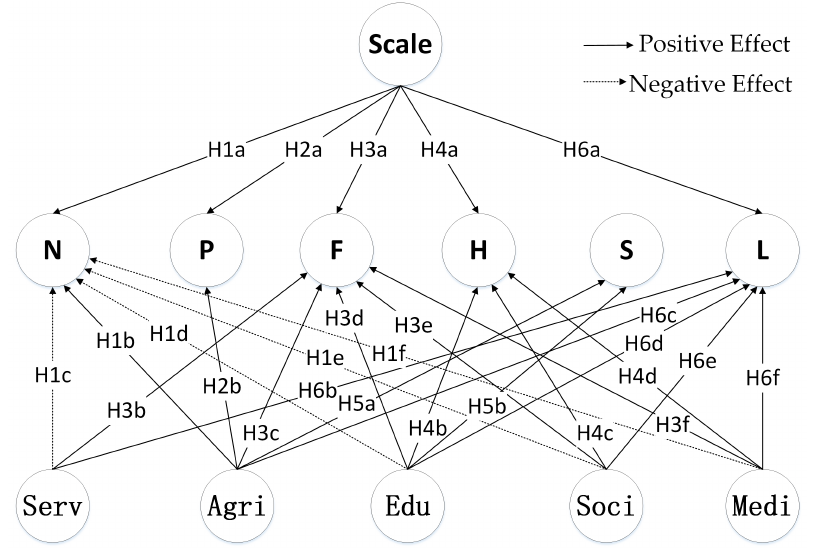
Figure 2. Research